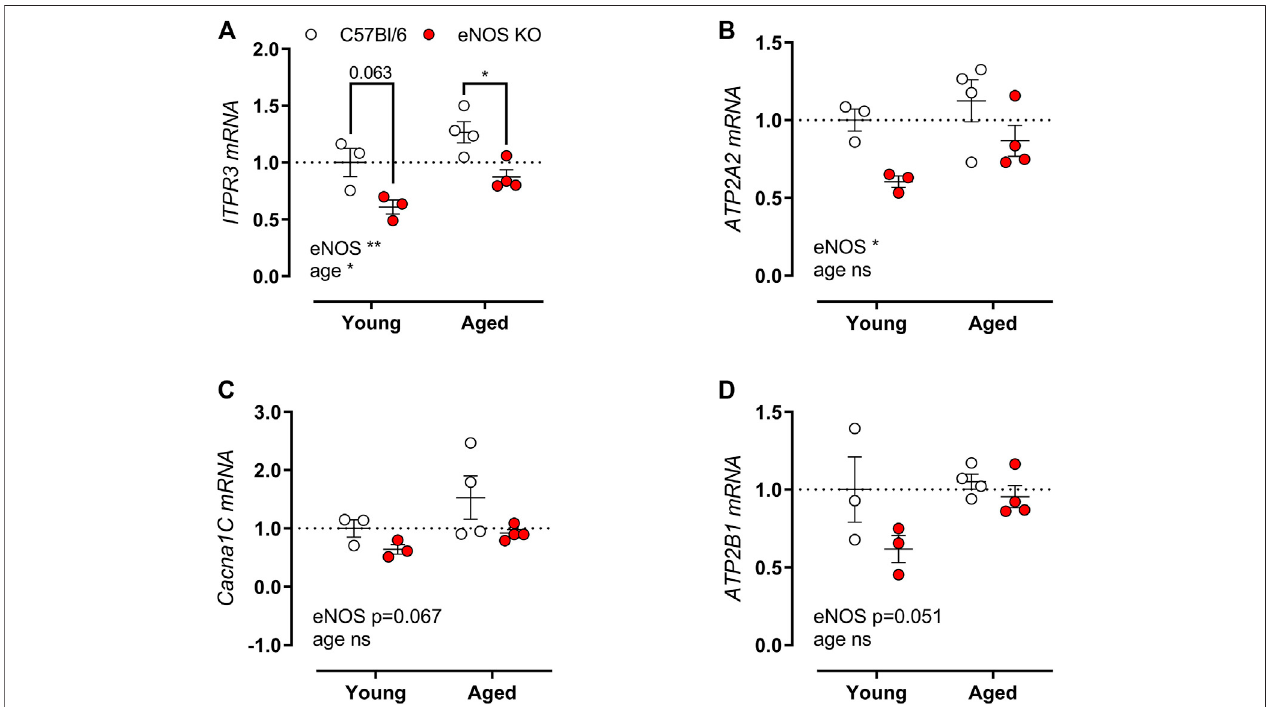
FIGURE 8 | Altered calcium channel gene expression in eNOS knockout mice. Gene expression of ITPR3 (A) , Cacna1C (B) , ATP2A (C) , and ATP2B1 (D) was assessed using qPCR on aortic tissue lysates of young (4 months, n = 3) and aged (13 months, n = 4) eNOS knockout and young (4 months, n = 3) and aged (14 months, n = 4) C57Bl/6 control mice. mRNA expression was expressed as a fold-change compared to young C57Bl/6 control values. Statistical analysis was preformed usingtwo-wayANOVA. Overall signi fi cance (bottom) and post-hoc signi fi cance (in graph) arelisted.ns, p > 0.05, *, p < 0.05, **, p < 0.01; ***, p < 0.001.